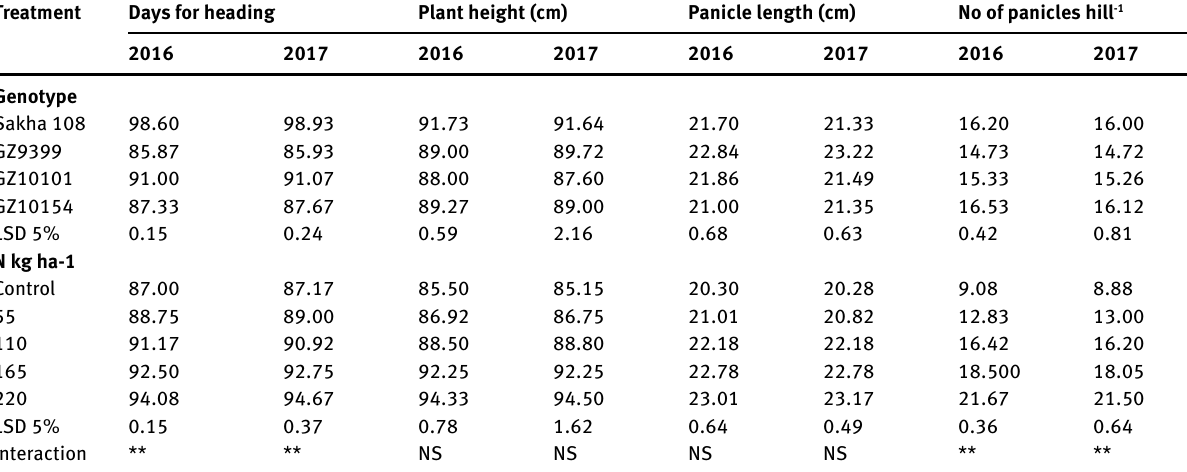
Table 2: Days to complete heading, plant height, panicle length and number of panicles hill -1 of rice genotype as affected by nitrogen levels in 2016 and 2017 growing